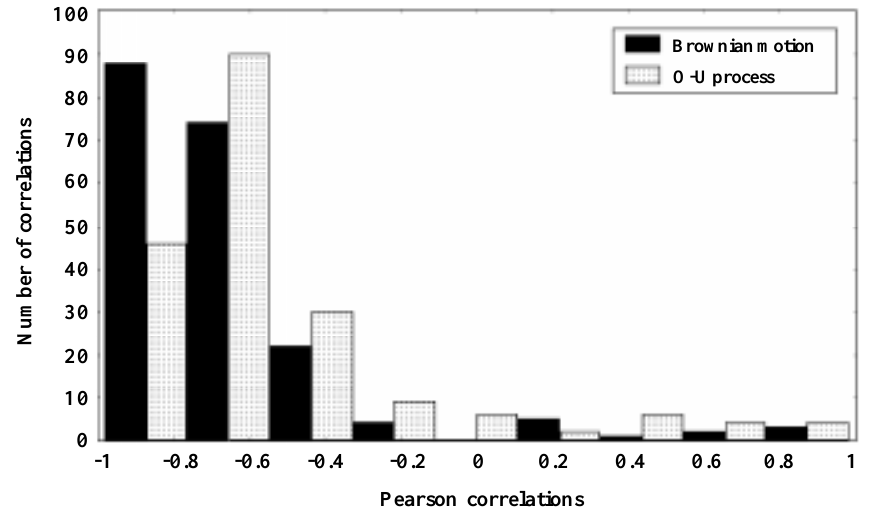
Figure 5 - Distribution of gradient correlations (Pearson correlations between Moran’s I and phylogenetic distance) in the correlograms of simulated evolution generated by Brownian motion and O-U